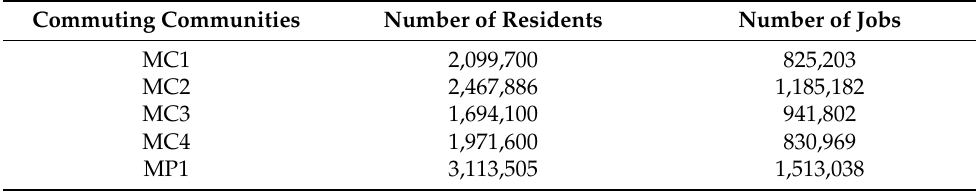
Table 3. The number of residents and jobs of commuting communities in Tianjin metropolitan area. Commuting